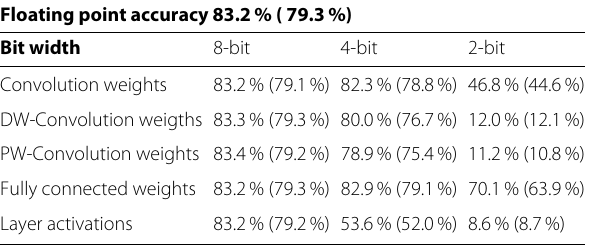
Table 5 Single-inference accuracies of networks with individually quantized network